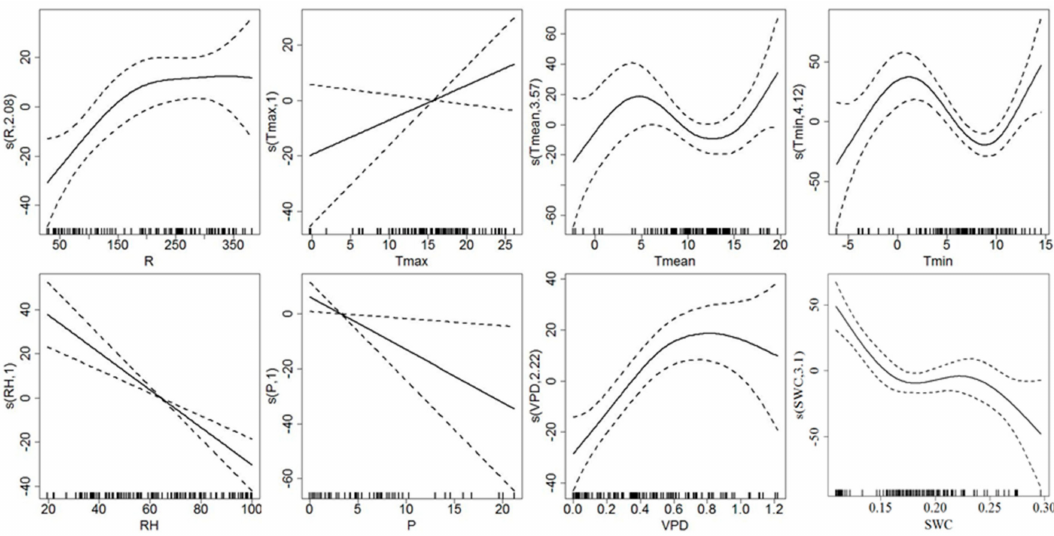
Figure 5. Effects of environmental variables on tree water deficit. Each graph is a modelled GAM output. Tick marks on the x -axis are observed data points. The y -axis represents the spline function, and the numbers are degree of freedom. Dashed lines indicate 95% confidence